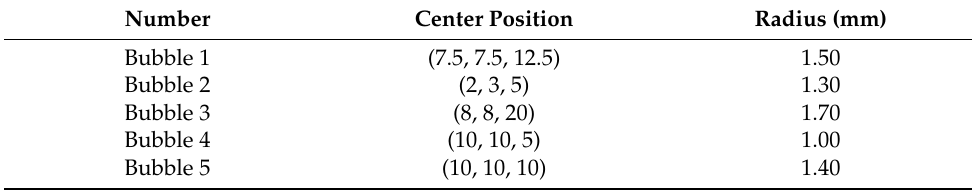
Table 3. The center position and radius of 5